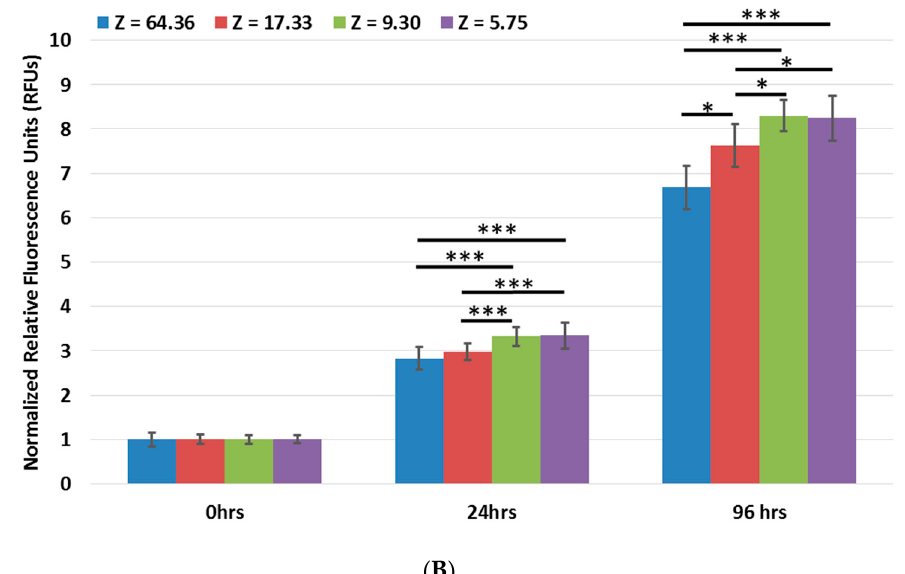
Figure 2. ( A ) Representative images of printed cells (constant cellular concentration of 1.0 mil cells/mL) at different time intervals (scale bar: 200 µm); ( B ) A graph showing the long-term viability of printed cell droplets at different time intervals post-printing (mean ± SD). Significance levels are as follows: p < 0.005 (***), p < 0.05 (*) .